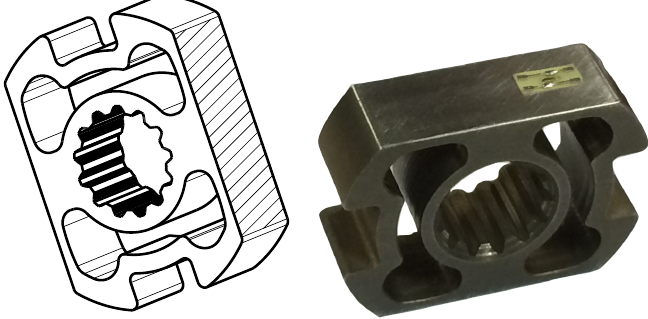
Figure 2. New square-cut joint torque sensor. ( left ) drawing highlighting the smooth surfaces where strain gauges can be glued on both wings; ( right ) a picture of the